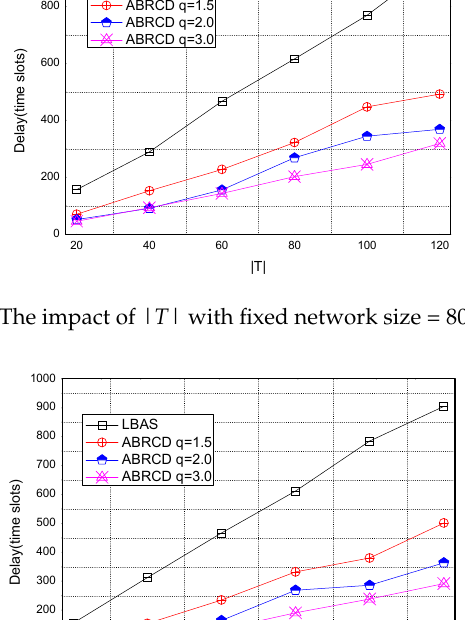
Figure 40. The impact of | T | with fixed network size = 600 on delay.